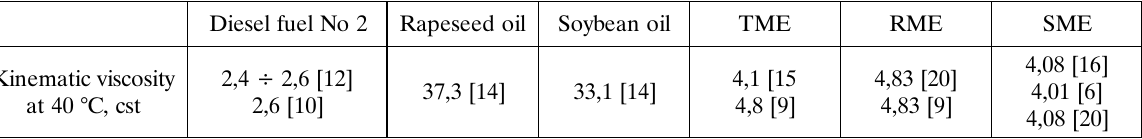
Table 5. Viscosity of